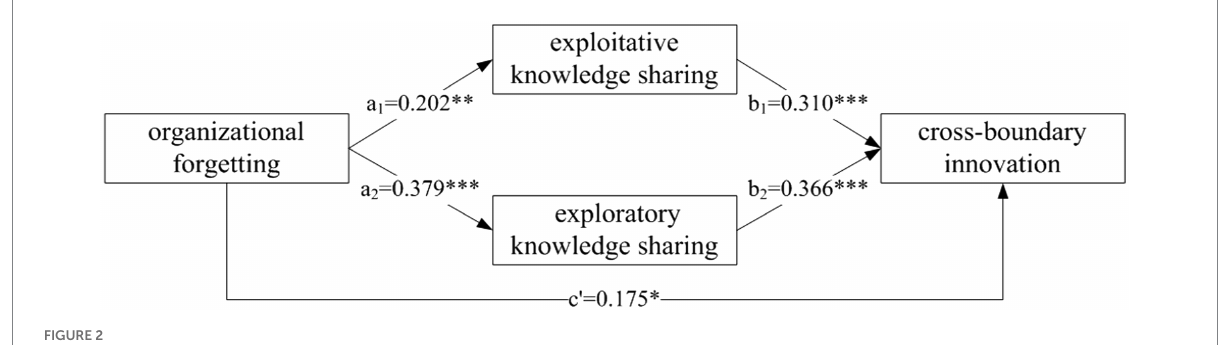
FIGURE 2 Path diagram of mediation effect of binary knowledge